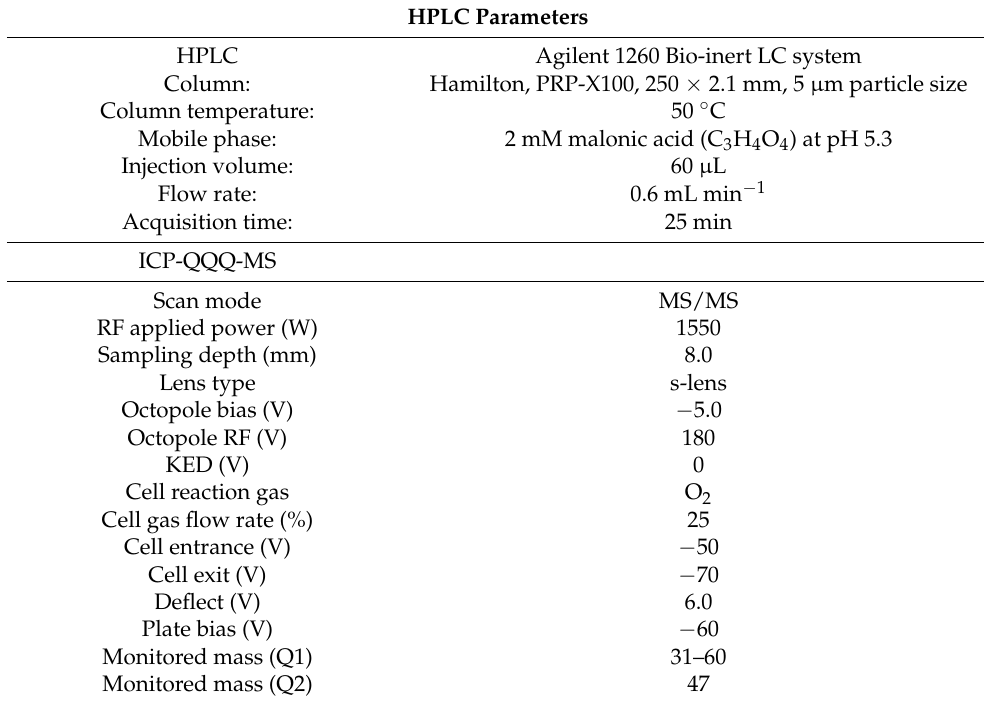
Table 4. The operating conditions of the anion exchange chromatography combined with inductively coupled mass spectrometry triple quadrupole